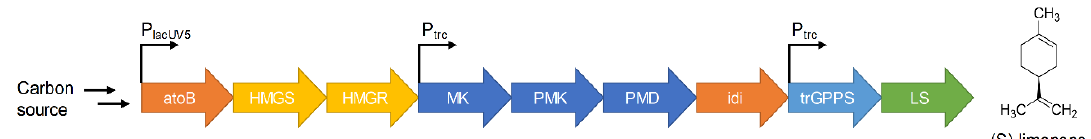
Figure 1. The heterologous mevalonate (MVA) pathway and limonene synthase introduced into Escherichia coli for the production of (S)-limonene. Acetoacetyl-CoA synthase from E. coli (atoB), HMG-CoA (hydroxymethylglutaryl-CoA) synthase from Saccharomyces cerevisiae (HMGS), an N-terminal truncated version of HMG-CoA reductase from S. cerevisiae (HMGR), mevalonate kinase (MK), phosphomevalonate kinase (PMK), phosphomevalonate decarboxylase from S. cerevisiae (PMD), isopentenyl diphosphate isomerase from E. coli (idi), a truncated and codon-optimized version of geranyl pyrophosphate synthase from Abies grandis (trGPPS), and a truncated and codon-optimized version of limonene synthase from Mentha spicata without the plastidial targeting sequence (LS).